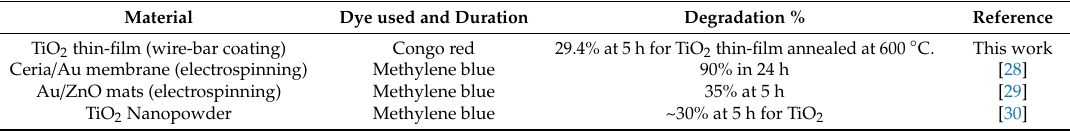
Table 1. Comparison of dye degradation activity of TiO 2